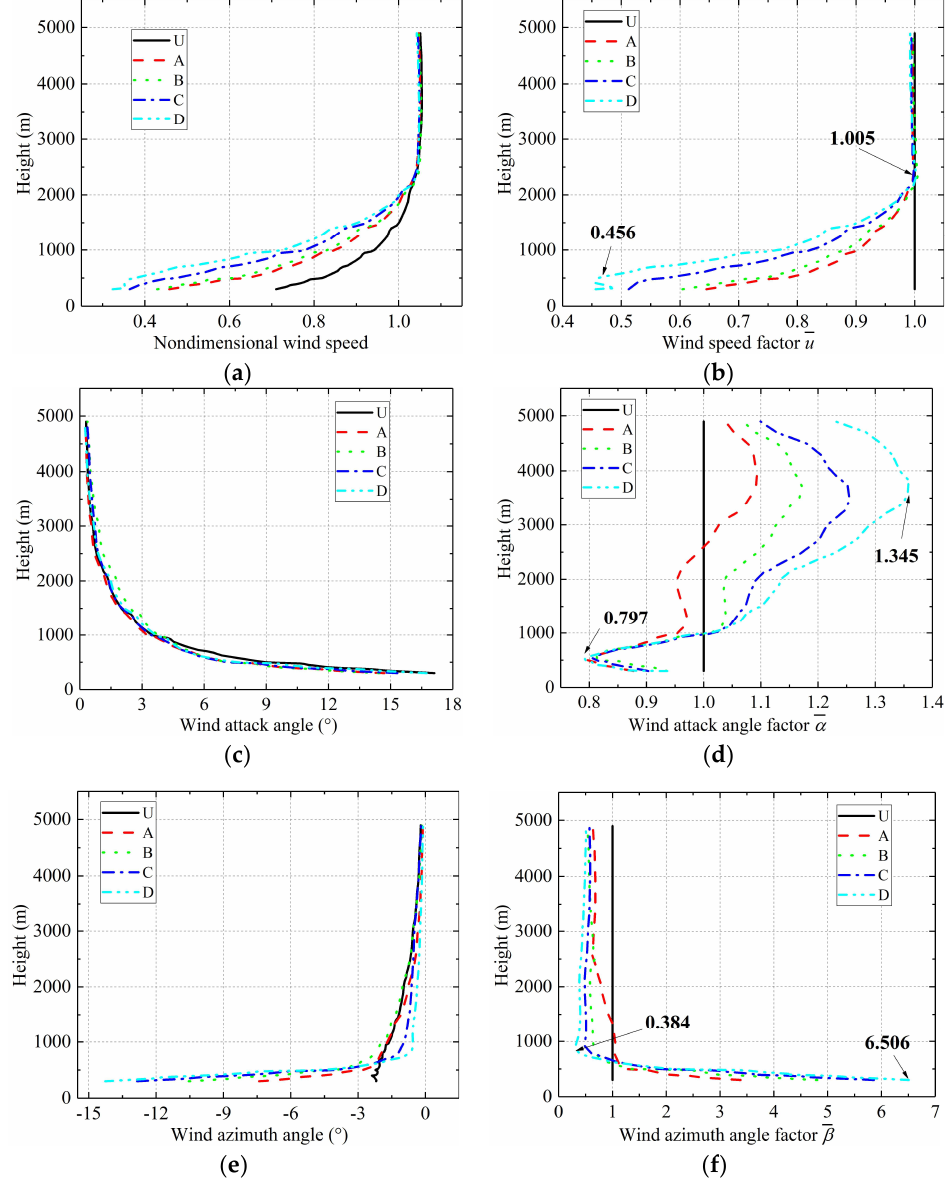
Figure 8. Influence of wind speed profile on wind parameters: ( a ) Nondimensional wind speed profile; ( b ) Nondimensional wind speed factor; ( c ) Wind attack angle profile; ( d ) Wind attack angle factor; ( e ) Wind azimuth angle; ( f ) Wind azimuth angle factor.